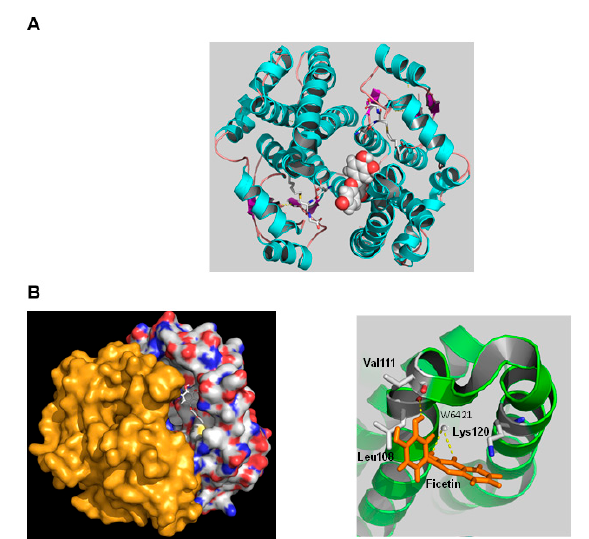
Figure 5. ( A ) Predicted favorable binding mode of fisetin in hGSTA1-1. Fisetin is shown as spheres. The bound inhibitor S-hexyl-GSH, overlapping both the G- and H-sites, is shown in a stick representation and colored according to the atom type. ( B ) Fisetin is shown in a stick representation, and the enzyme subunits are shown as surface (left). The fisetin-bound subunit is colored according to the atom type. Important side chains that contribute to interaction are shown in a stick representation, colored according to the atom type and labeled (right).